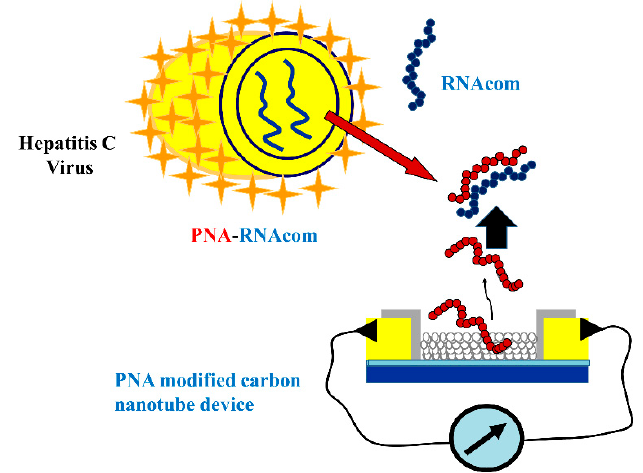
Figure 14. A scheme of peptide nucleic acid (PNA) functionalized single-walled carbon nanotube (SWCNT) field effect transistor device for the detection of HCV (Reproduced with permission from [102]).